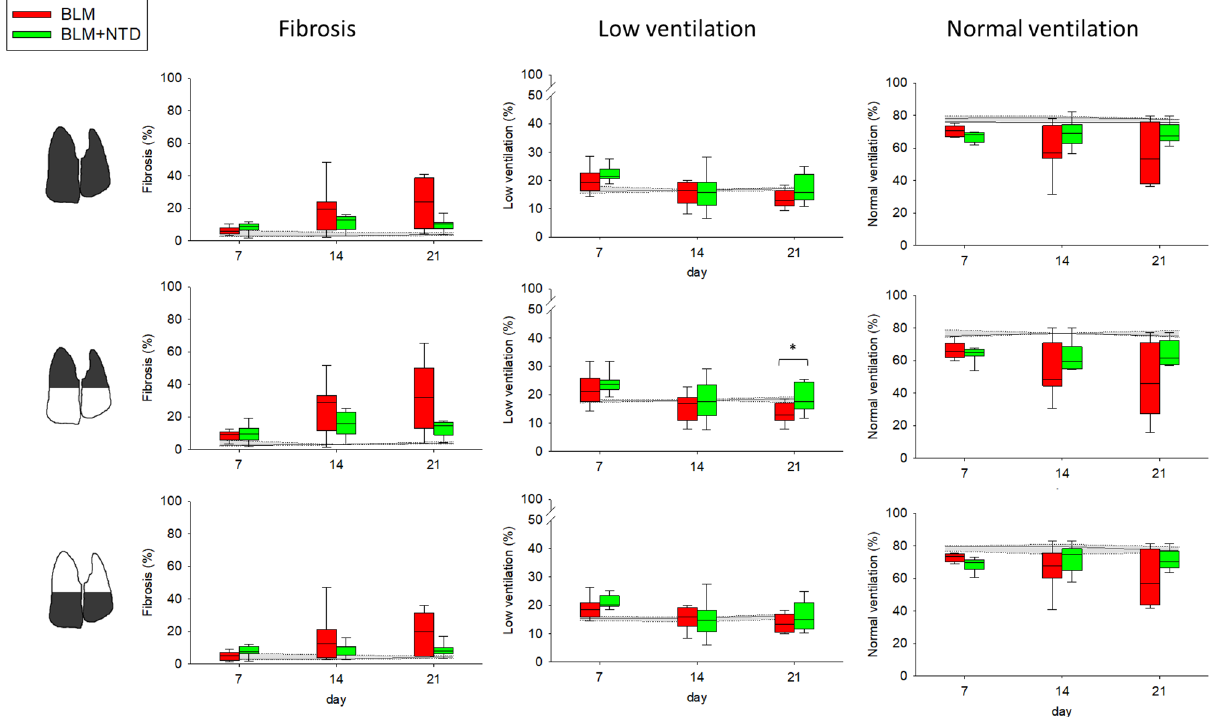
Figure 7. Percent extension of fibrosis (first column), low ventilation (second column) and normal ventilation (third column) in the BLM (red) and BLM + NTD (green) group. The analysis was performed separately for the overall lung (top row), upper lung regions (middle row) and lower lung regions (bottom row). Gray area represents the saline values and is delimited by the 25th and the 75th